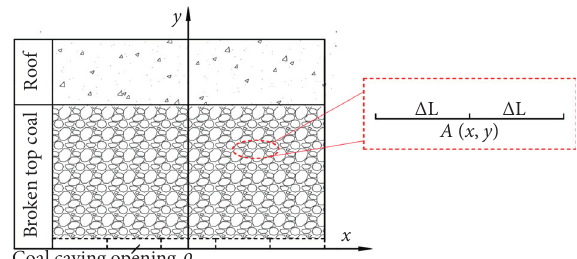
Figure 2: Two-dimensional coordinate system along the working face.